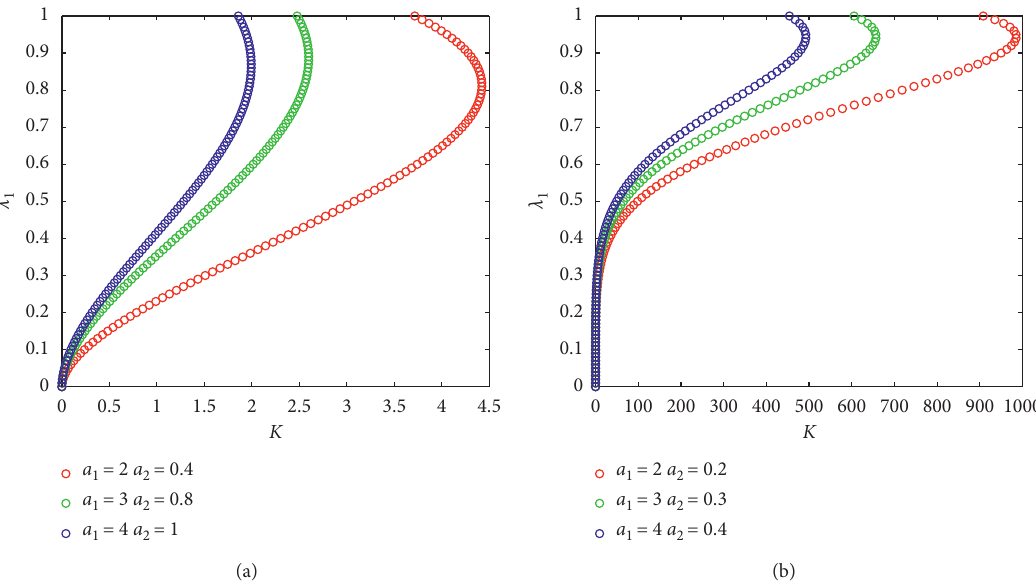
Figure 2: When 0 < a < ( α /2 ) a , the influence mechanism of fixed asset investment on the income distribution coefficient of pension 2 1 institutions. (a) α > β . (b) α < β